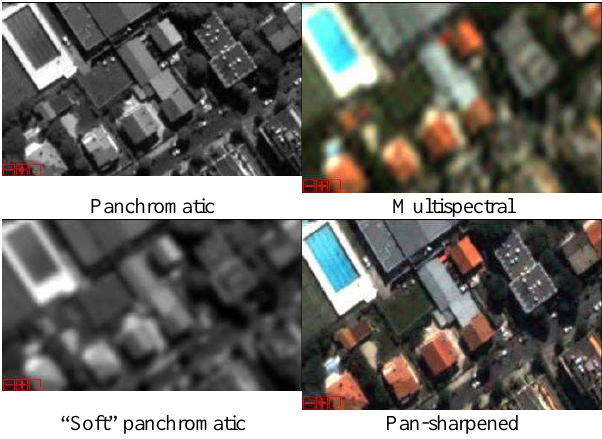
Figure 11. Pleiades Pan sharpening 4 steps algorithm